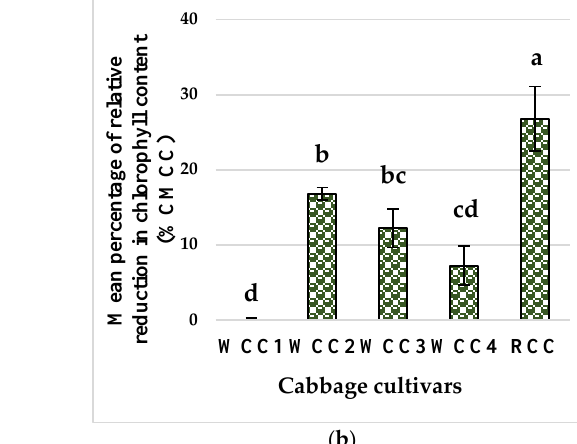
Figure 2. Mean phenotypic expression of chlorophyll content. ( a ) CM1000™ chlorophyll content index values and ( b ) mean percentage of relative reduction in chlorophyll content in five cabbage cultivars under HS (at 42 °C; for 5h) and NS (25 °C) conditions. Bars denote the mean of at least 5 measurements ± SE ( n = 5). Mean values within each cultivar with different letters are significantly different based on Tukey’s HSD test at p < 0.05.